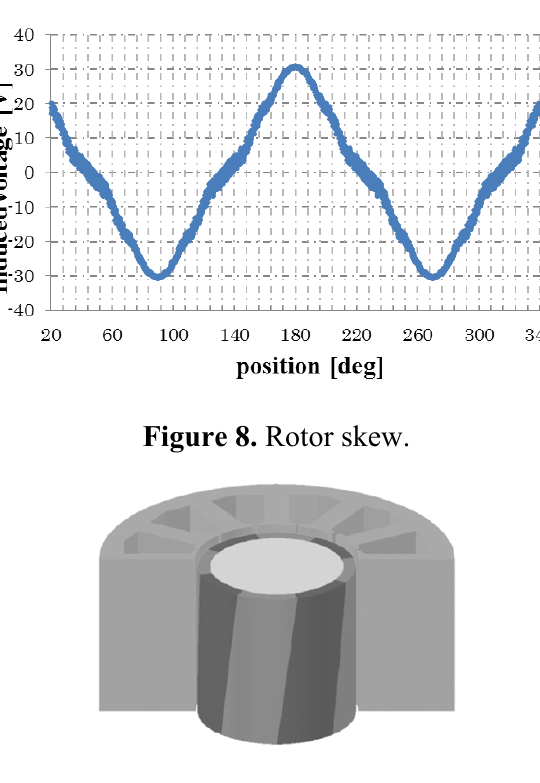
Figure 7. Induced voltage of a skewed rotor (Phase-a).